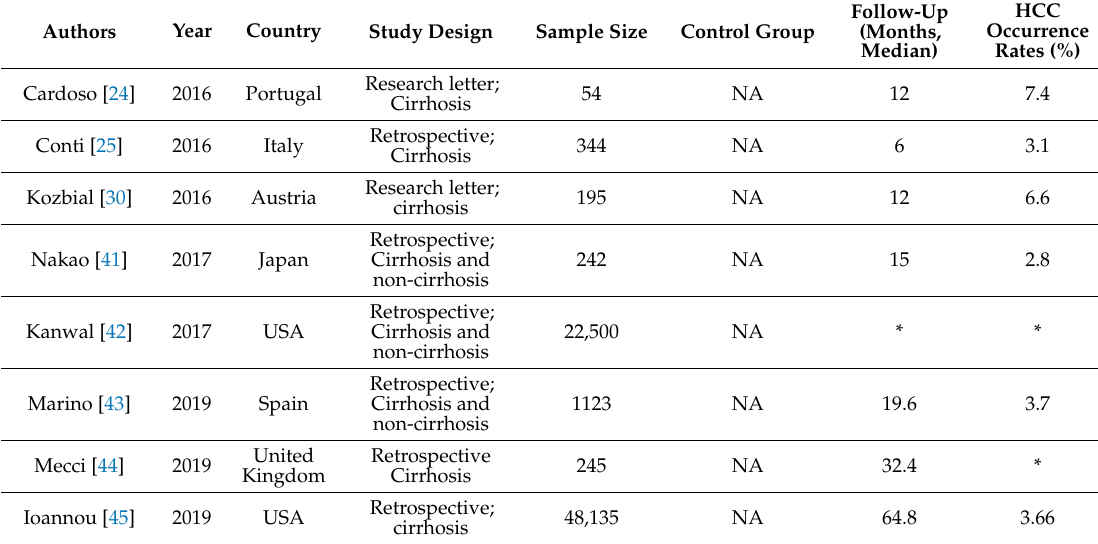
Table 2. Retrospective study of HCC occurrence after SVR by